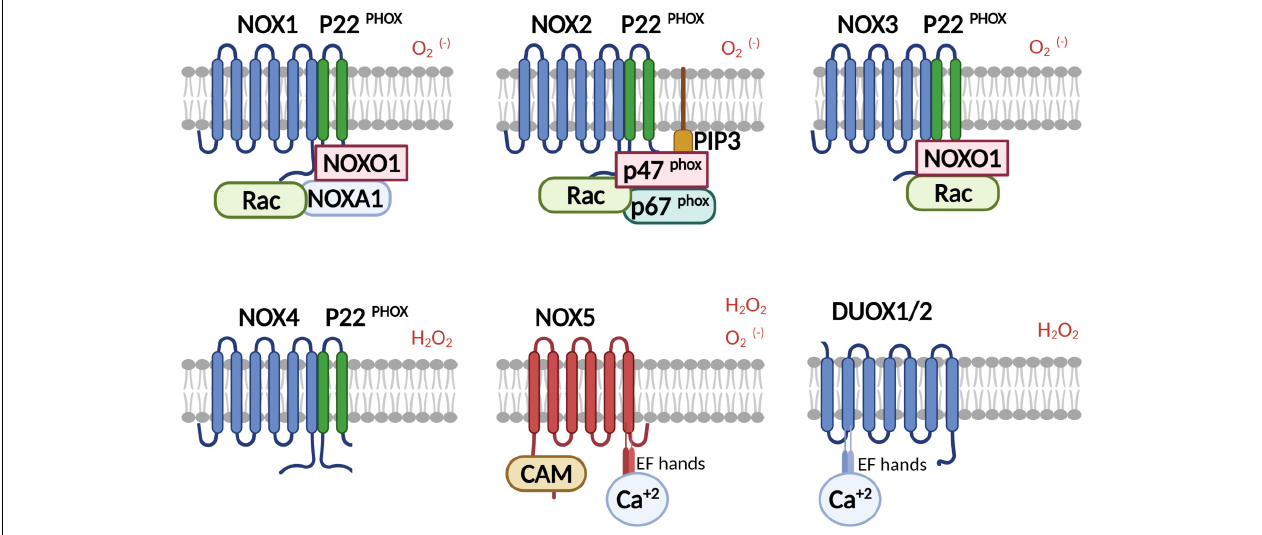
FIGURE 1 | Schematic representation of the family of NADPH oxidases. NOX isoforms and regulatory subunits: NOX1-3 are activated in the presence of cytosolic phox proteins, where PIP3 serves as a membrane anchor for p47 phox in the case of NOX2 activation. NOX1-3, and NOX5 release superoxide (in some cases NOX5 also hydrogen peroxide), whereas NOX4 and the DUOXes release only hydrogen peroxide. NOX4 is constitutively active and is regulated by expression. NOX5 and DUOX1/2 are calcium dependent through calcium-calmodulin binding or by the direct binding of Ca 2 + to EF-hands in DUOXes,